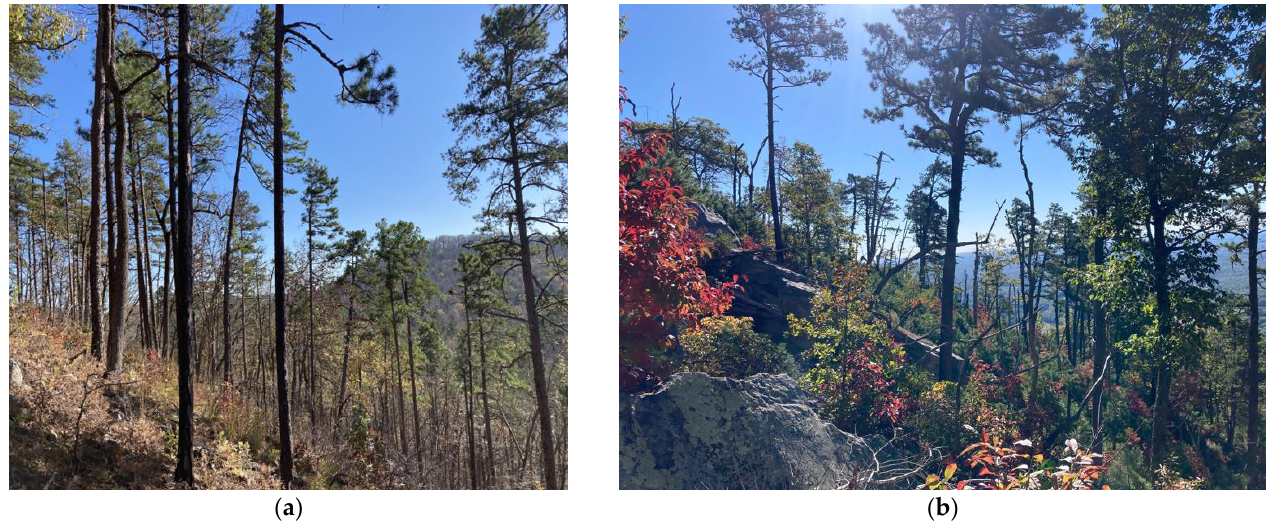
Figure 1. Rocky south-facing slope in ( a ) the Uwharrie Mountains, Uwharrie National Forest, NC, USA; and ( b ) the Sauratown Mountains, Pilot Mountain State Park, NC, USA. Longleaf, shortleaf, and Virginia pine co-occur in ( a ), and pitch pine occurs in ( b ).